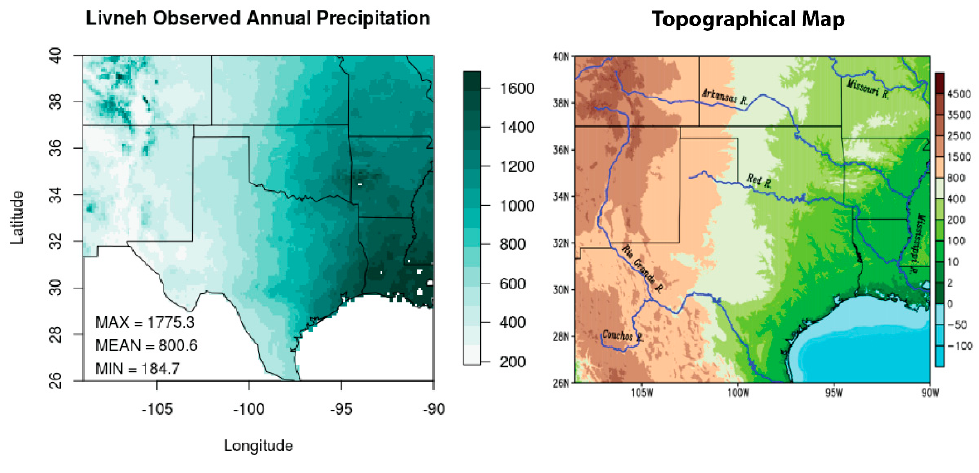
Figure 1. Left—Study domain overlaid with annual average precipitation (mm) from Livneh v. 1.2 [37]. Right—Topographical map for the study domain: The elevation map of south-central United States with major rivers overlaid on it. Brown / green shading denotes elevation (in units of m), while the rivers are outlined in blue. Topography, bathymetry and shoreline data are obtained from the National Oceanic and Atmospheric Administration (NOAA) National Geophysical Data Center’s ETOPO1 Global Relief Model [38]. This is a 1 arc-minute model of the Earth’s surface developed from diverse global and regional digital datasets and then shifted to a common horizontal and vertical datum. River shapefiles are obtained from the Global Runoff Data Centre’s Major River Basins of the World [39].